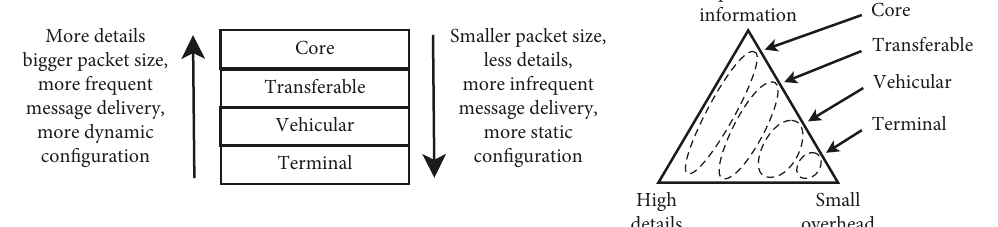
Figure 7: Relation of the management trilemma to the